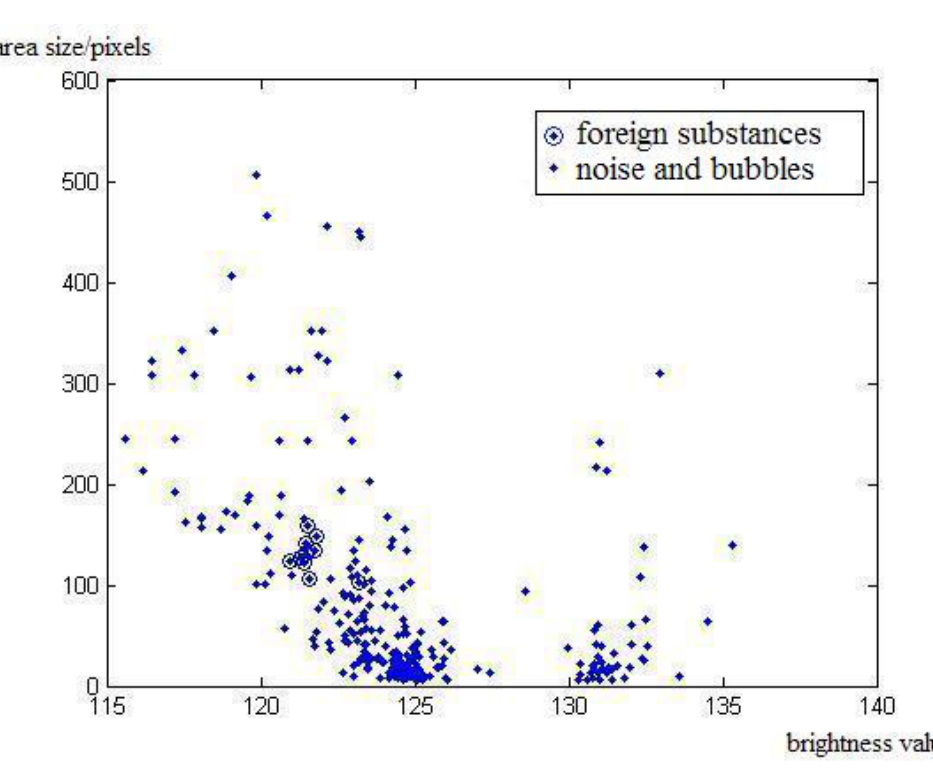
Figure 3. Distribution of brightness value and area size in a sequence of